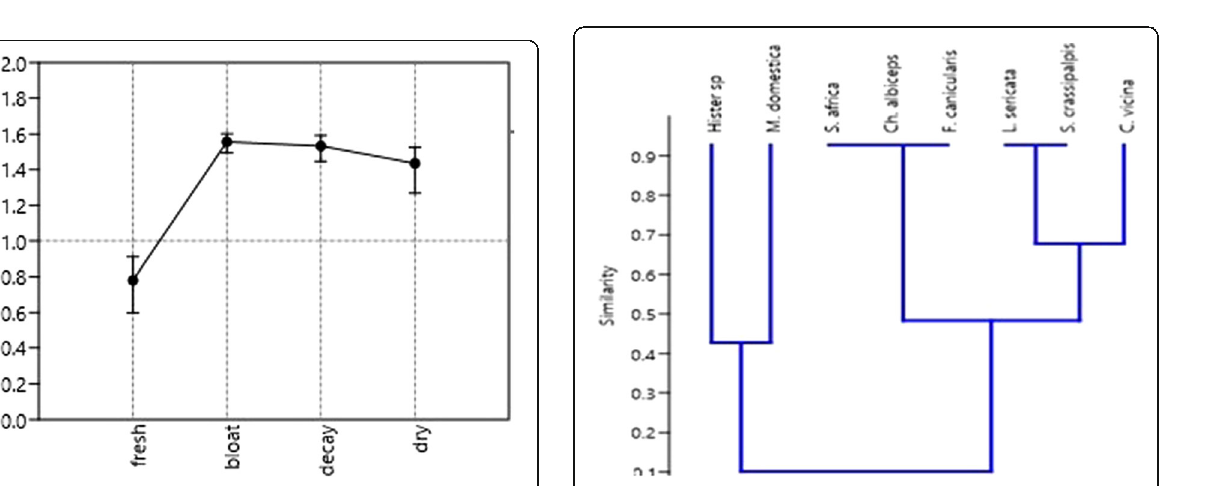
Fig. 5 Shannon index value for each cadaveric decomposition stage Fig. 6 Cluster analysis based on Jaccard ’ s distance in the indoor habitat; cophenetic correlation =